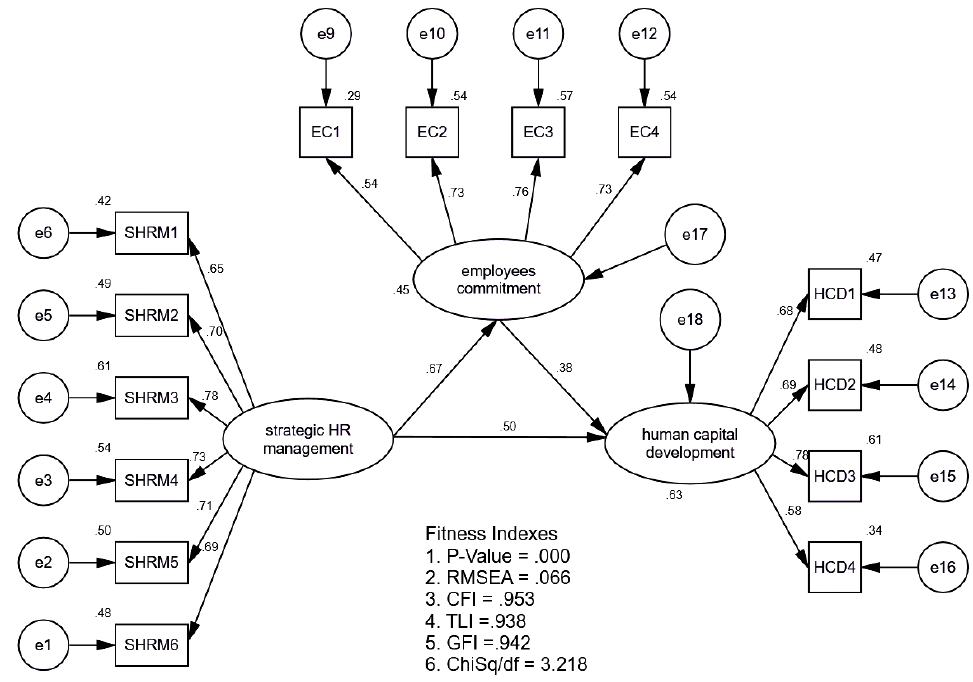
Figure 4. Standardized regression weights between variables